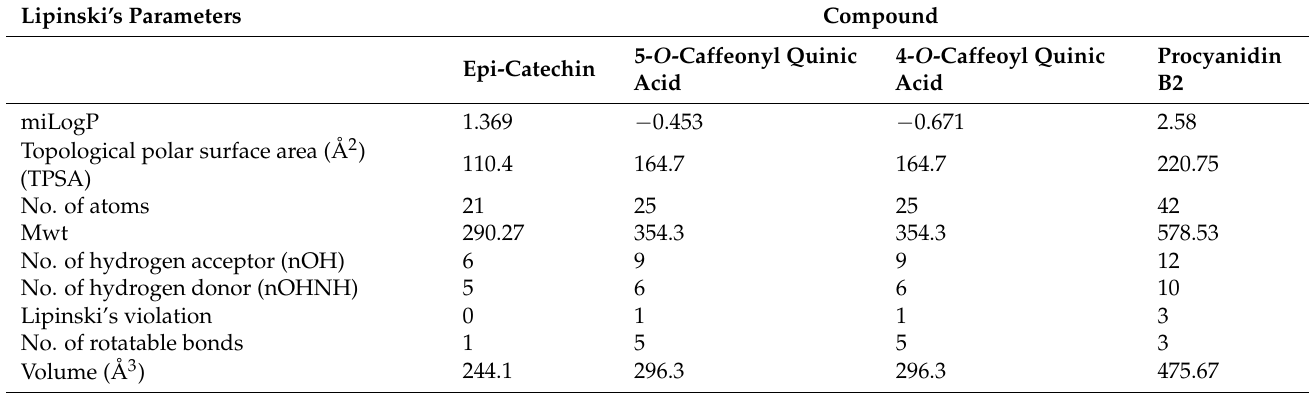
Table 2. Physicochemical properties of compounds isolated from